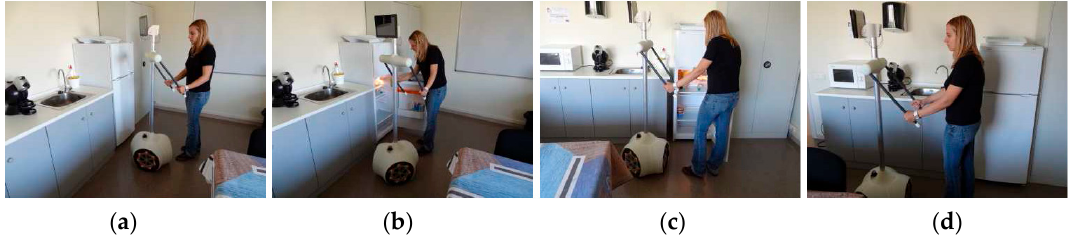
Figure 16. Applications ( a – d ) of the APR as a support for walking.